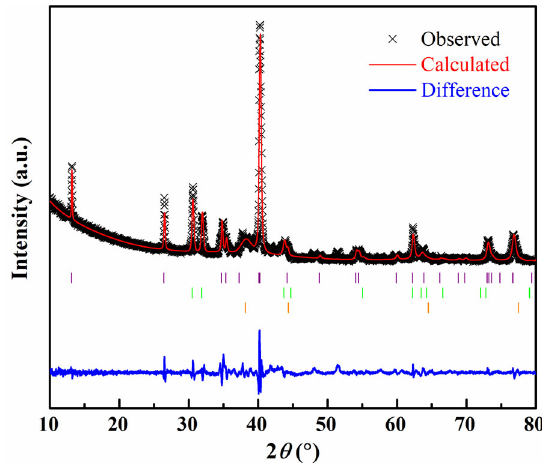
Fig. 6 Comparison between the observed (black crosses) and calculated XRD (red line) patterns of V 2 SnC. The deviation plot (blue line) is shown in the lower part of Fig. 6. The purple, green, and orange ticks below the pattern represent the peak positions of the V 2 SnC, Sn, and VC 0.75 phases,